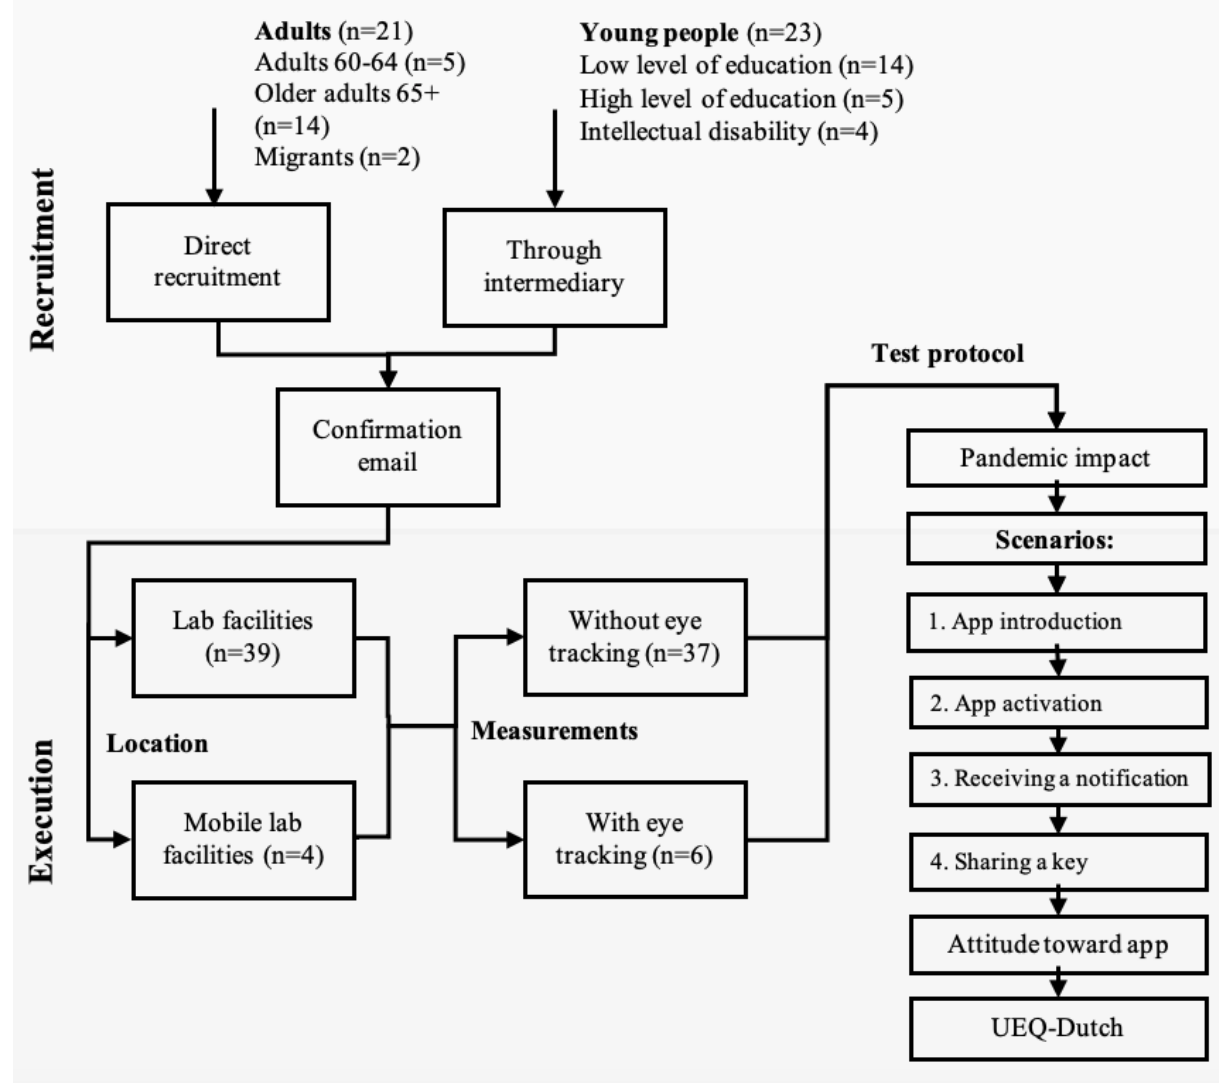
Figure 1. Flowchart of study recruitment and procedure. The top part visualizes the recruitment methods, through both direct (n=21) and indirect (via intermediaries/representatives, n=23) channels. Included participants were tested in a stationary and mobile lab, with or without additional eye tracking, following the test protocol depicted on the right. UEQ-Dutch: Dutch User Experience